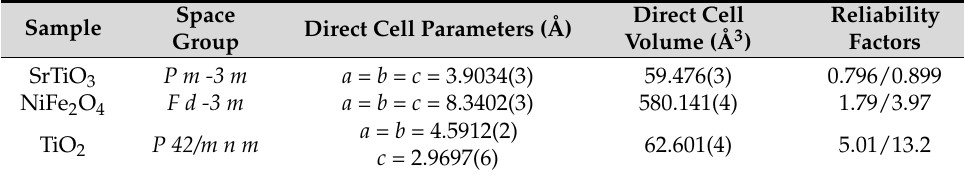
Figure 1. Powder XRD diffractograms of ( a ) pure cubic spinel phase NiFe 2 O 4 synthesized by sol-gel auto-combustion method, ( b ) 75 STO/ 25 NFO porous-foam nanocomposite formed by joint solid-state and sol-gel auto-combustion techniques and annealed at 1100 °C, and ( c ) pristine cubic perovskite phase SrTiO 3 synthesized by solid-state technique by mixing strontium carbonate and titanium dioxide with a molar ratio of 1:1 and thermal treated for 9 h at 1000 °C.